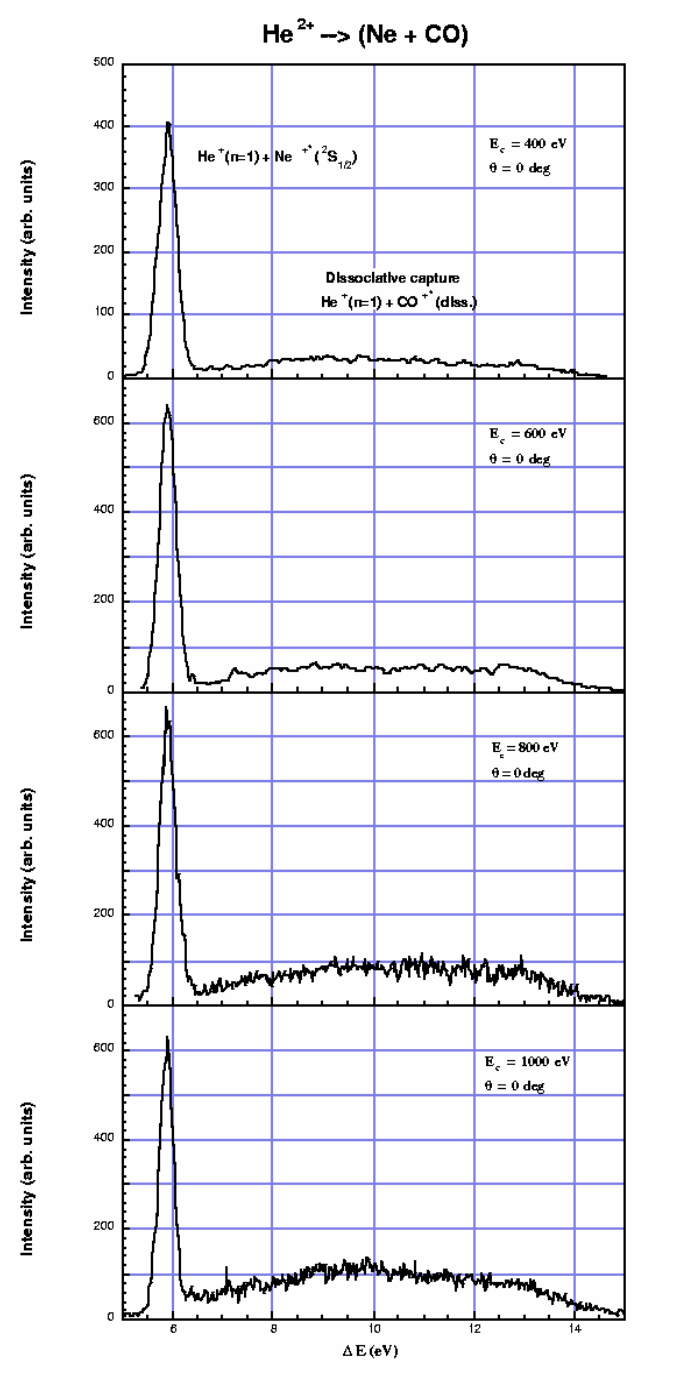
Fig. 5 : TES for dissociative SEC in He 2+ - CO collisions; the peak near 6 eV results from SEC in He 2+ -Ne collisions as utilized for calibration of the energy gain